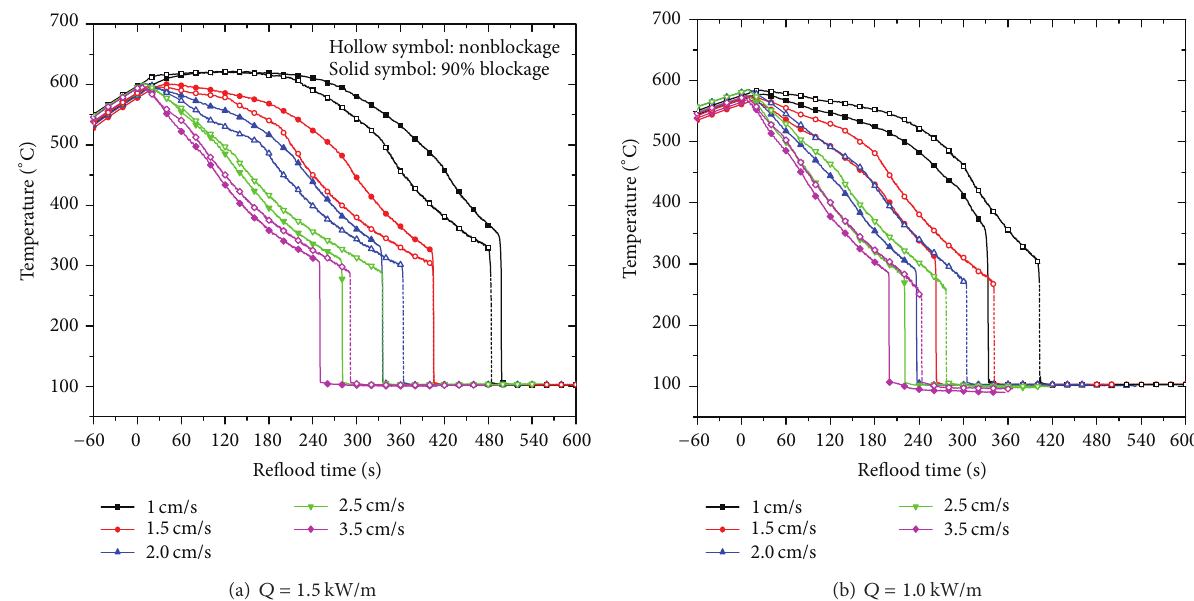
Hollow symbol: nonblockage Solid symbol: 90% blockage